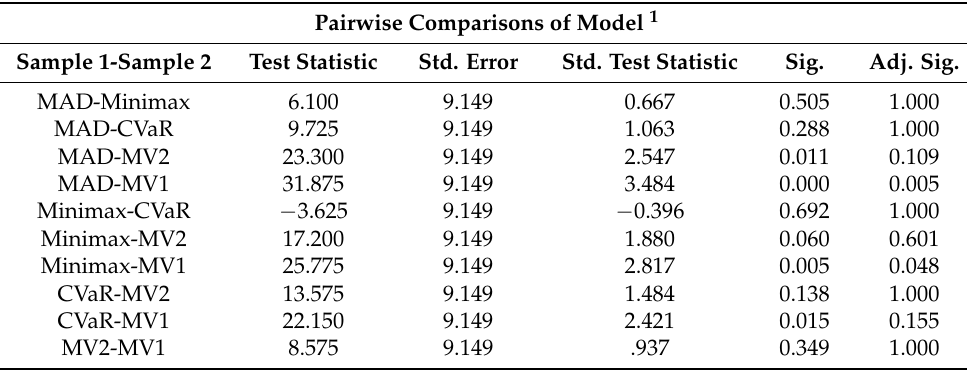
Table 6. Results of pairwise comparisons of model for Sharpe ratio ranking.